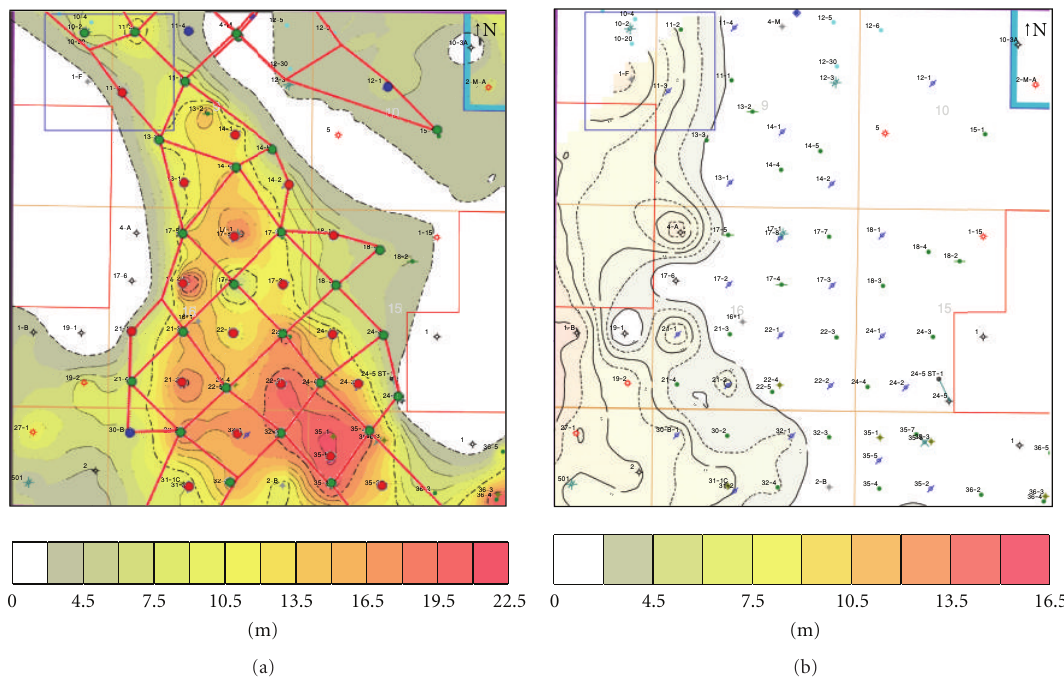
Figure 20: Gross sandstone thickness maps for (a) Morrow A sandstone and (b) Morrow A1 sandstone (courtesy Whiting Petroleum). The star in the map is the well used for elastic